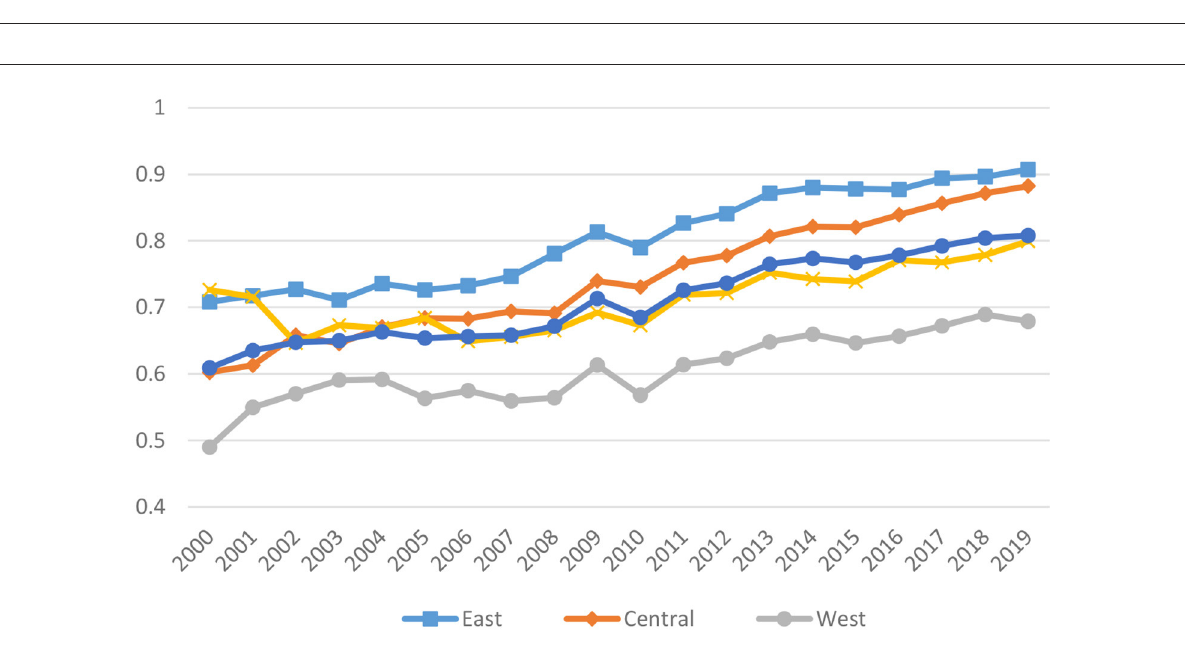
FIGURE3 Trends in the GTFP of the pharmaceutical industry in four